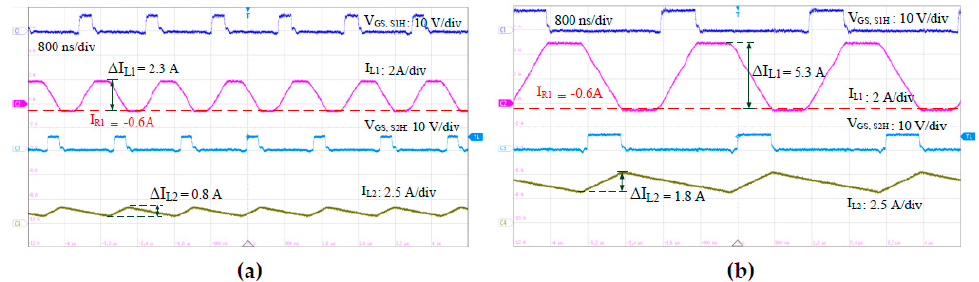
Figure 10. Inductor current waveforms in the forward direction with variable switching frequency: ( a ) at 20% load; ( b ) at 60% load.